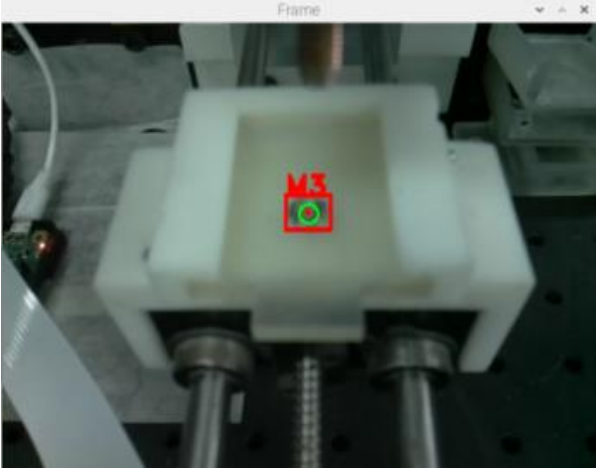
Figure 11. An example of a photo measured by the camera. The ROI is depicted as a green circle. This figure shows that the TH image is inside the ROI. Template matching using OpenCV [19] is applied to estimate the TH size in the ROI. Here, the estimated size is M3, which is